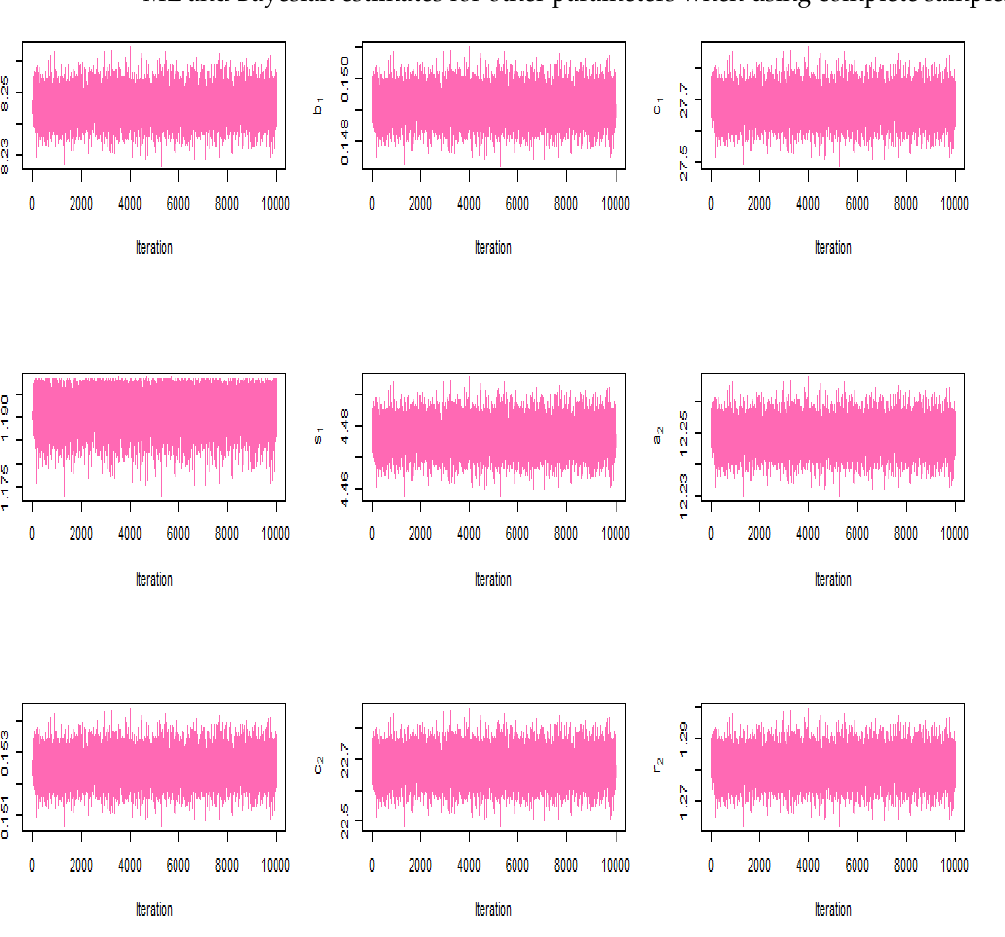
Figure 5. MCMC trace for results of Bayesian estimation of model for complete Bladder data for the last two parameters.